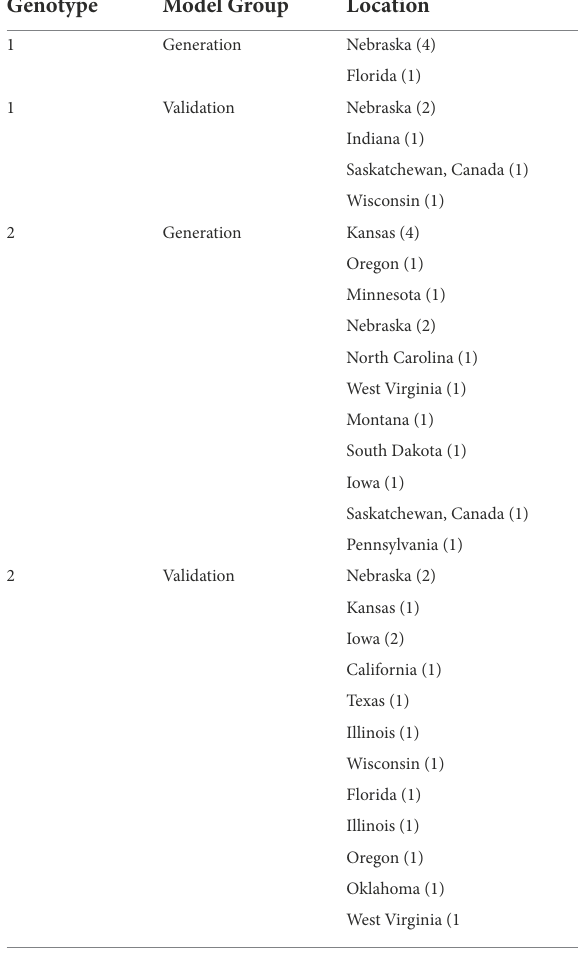
TABLE 1 State of origin and model groups assigned to the 39 strains used in this study.